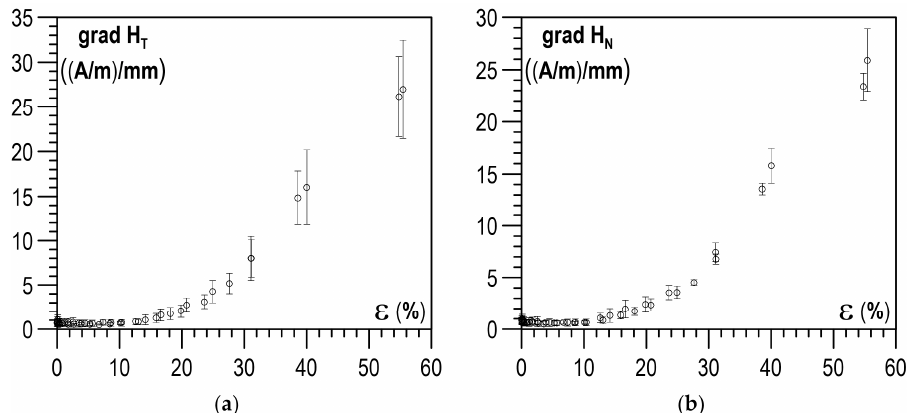
Figure 8. Relation between the maximum gradient value and the plastic deformation degree: ( a ) max gradient of tangential component grad H T ; ( b ) max gradient of normal component grad H N .